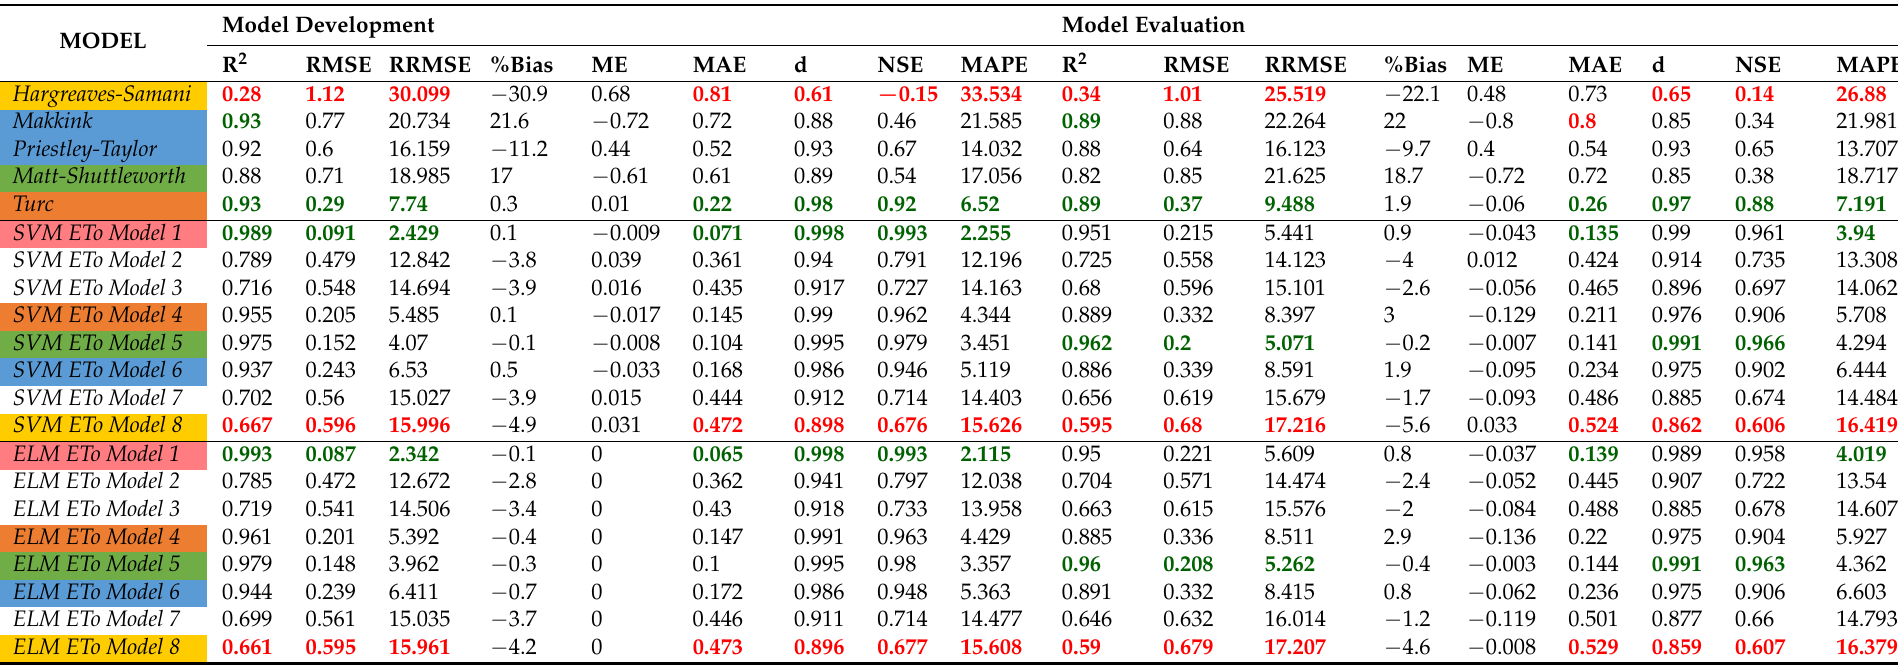
Table 10. Statistical values of empirical and machine learning models used for estimating daily ETo at Ambulong Station